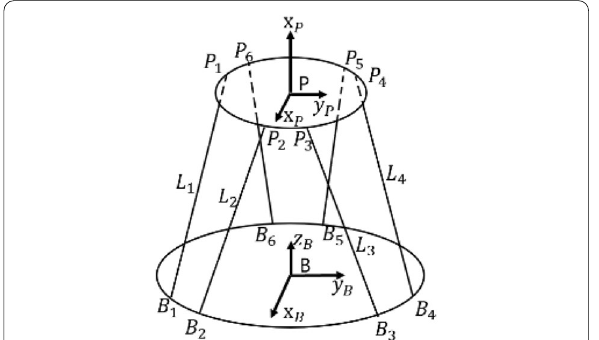
Figure 4 Mechanical schematic diagram of